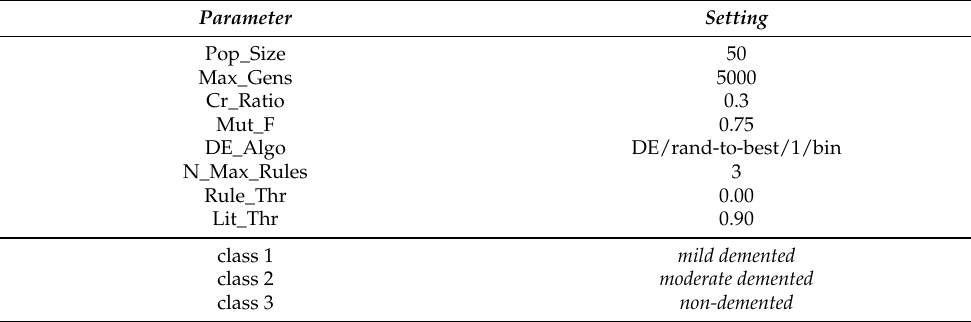
Table 6. The Parameter Setting for DEREx for the 3-Class Problem.